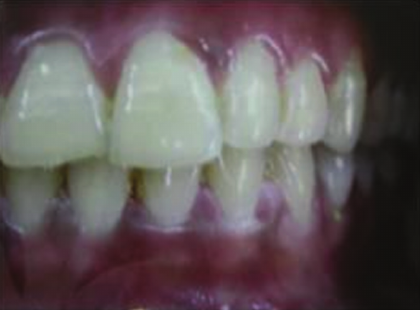
Figure3:Intraoralphotographshowingmaxillaryleftsupplemental lateral